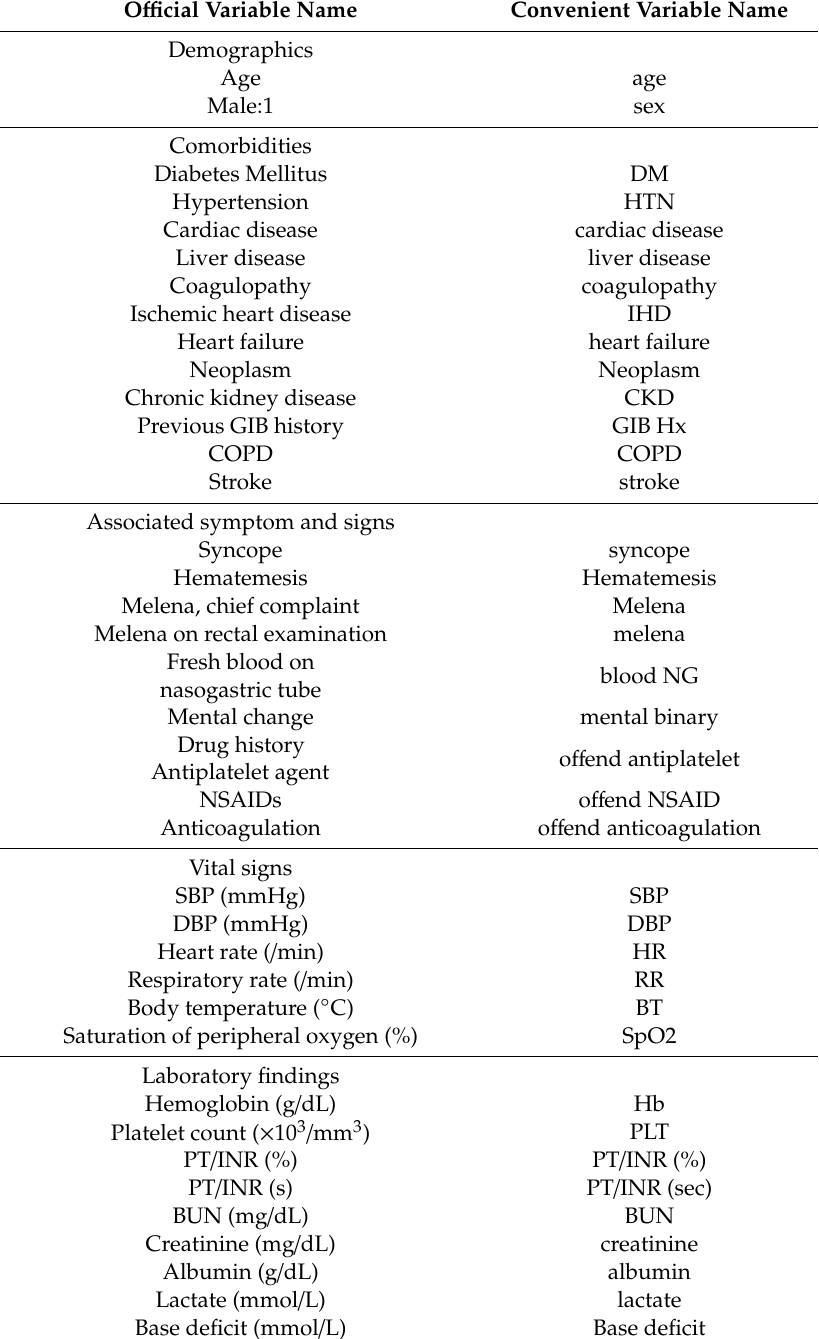
Table A1. (left) and those in model training and figures